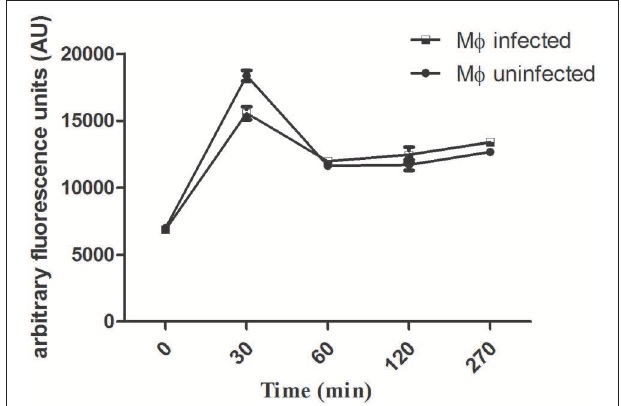
FIGURE 1 | Uptake of liposomal sertraline labeled with rhodamine 123 by Leishmania -infected and uninfected macrophages. The uptake was measured by the fluorescence intensity within macrophages using a flow cytometry (Attune-Thermofisher) for a period of 270min. A number of 10,000 events were analyzed for each